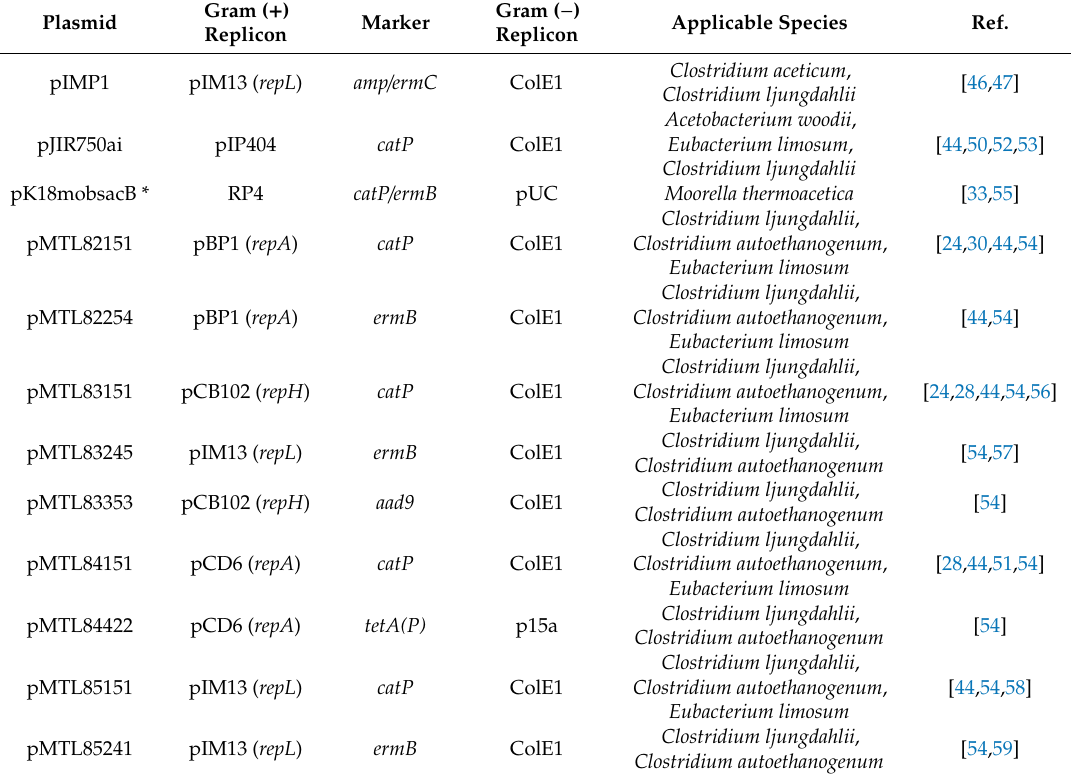
Table 1. Plasmid systems applicable to acetogens.